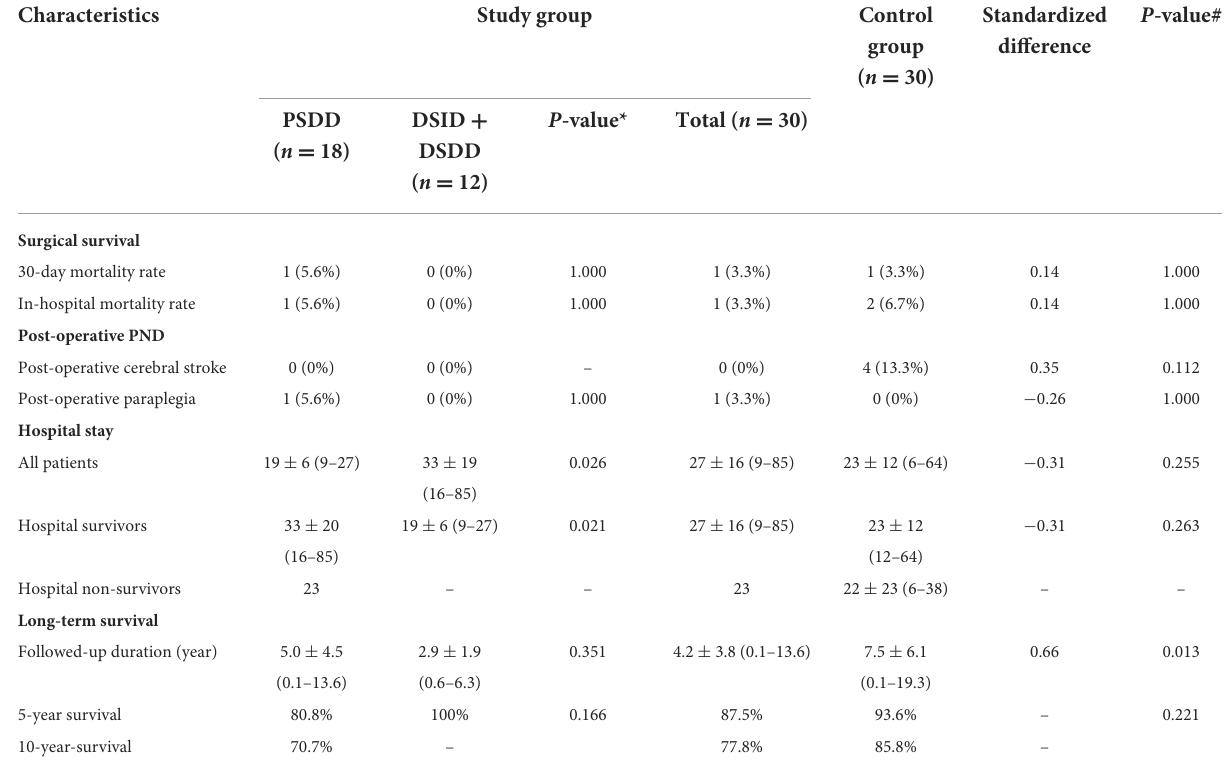
TABLE 3 Post-operative data.